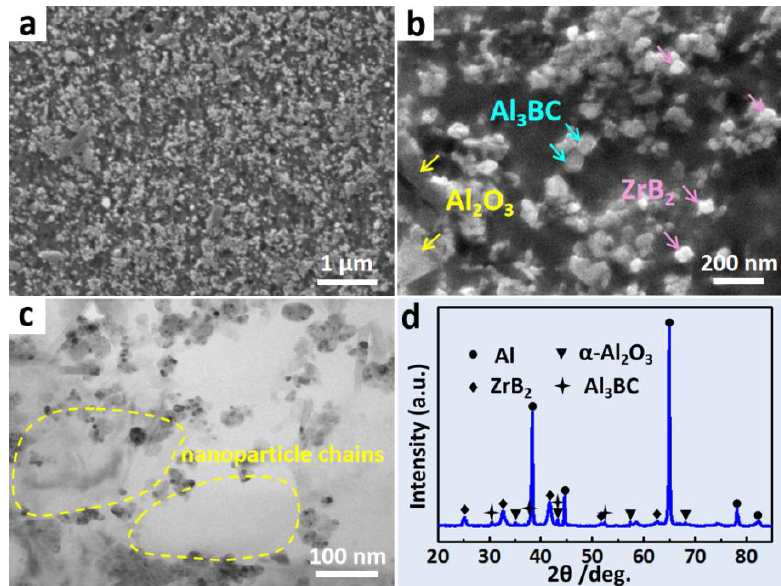
Figure 2. ( a , b ) The microstructure of the (ZrB 2 + Al 3 BC + Al 2 O 3 )/Al composite analyzed by FESEM; ( c ) The TEM image showing the nanoparticle chains; ( d ) is the XRD pattern.